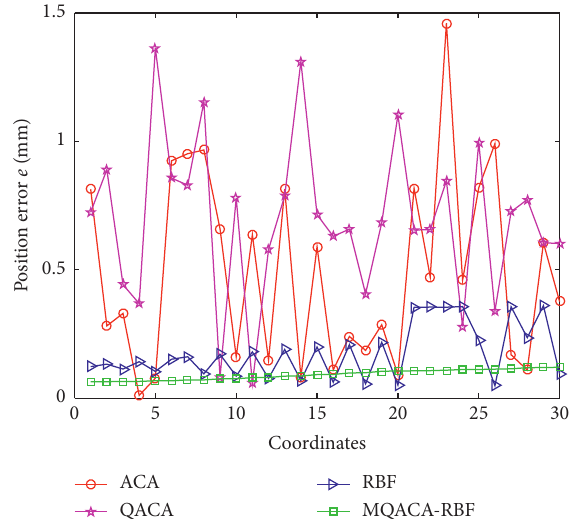
Figure 10: Location error comparison of selected